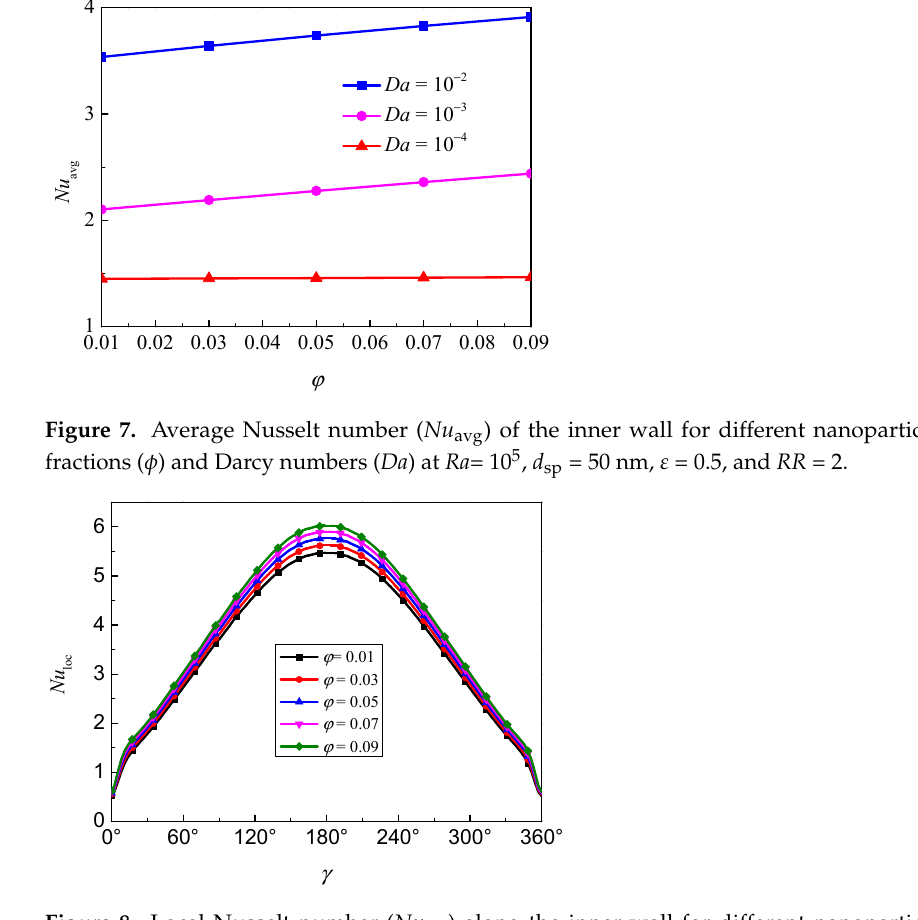
Figure 8. Local Nusselt number ( Nu loc ) along the inner wall for different nanoparticle volume fractions ( φ ) at Ra = 10 5 , Da = 10 − 2 , d sp = 50 nm, ε = 0.5, and RR = 2.